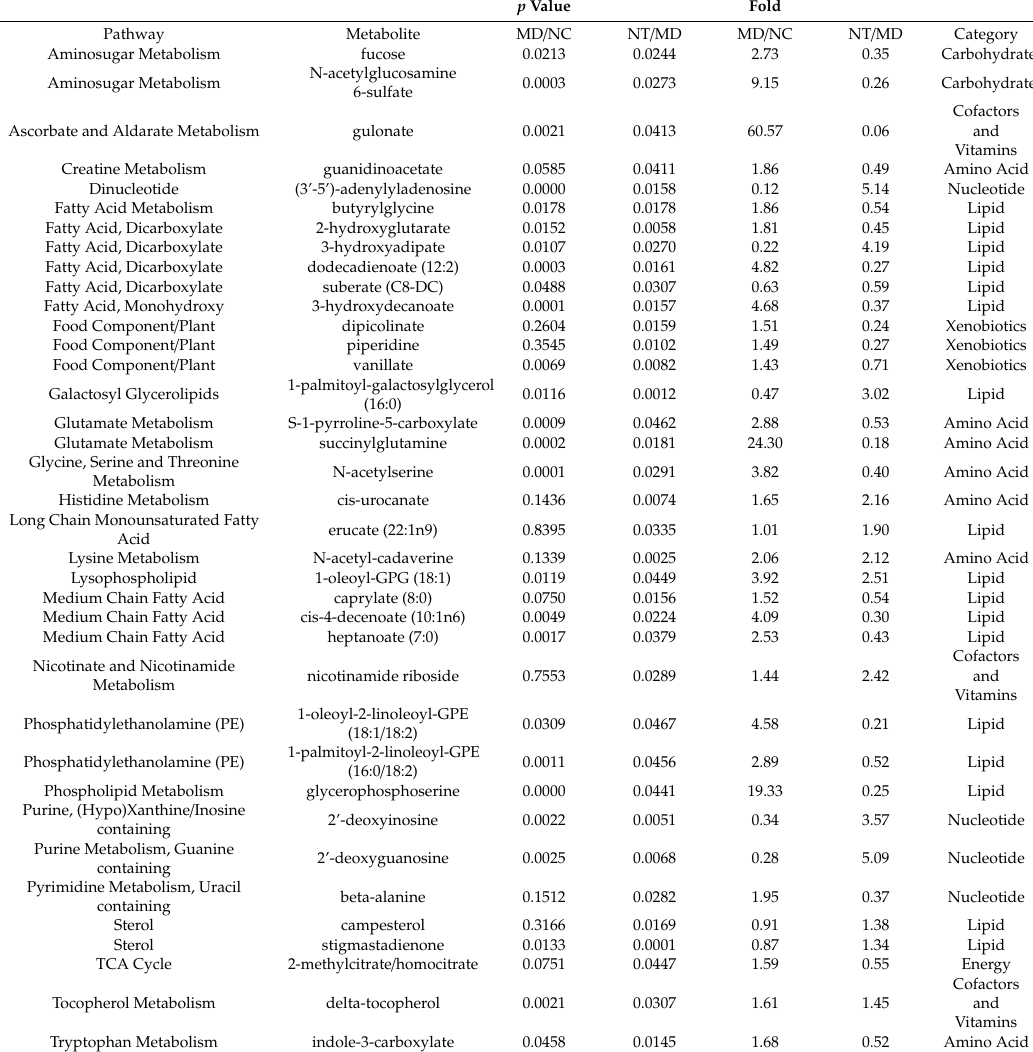
Table 1. Gut metabolites significantly a ff ected by neoagarotetraose supplementation. P value was calculated based on Wilcoxon Rank Sum testing. Fold was defined as the ratio of mean normalized ion counts of MD to NC or NT to MD. NC: normal baseline controls; MD: colitis induced by DSS; NT: DSS induced colitis mice supplemented with